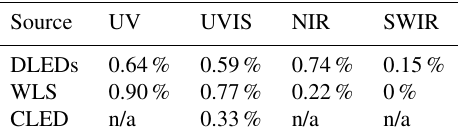
Table 2. The observed average approximate decrease in signal for the internal light sources per 1000 orbits.